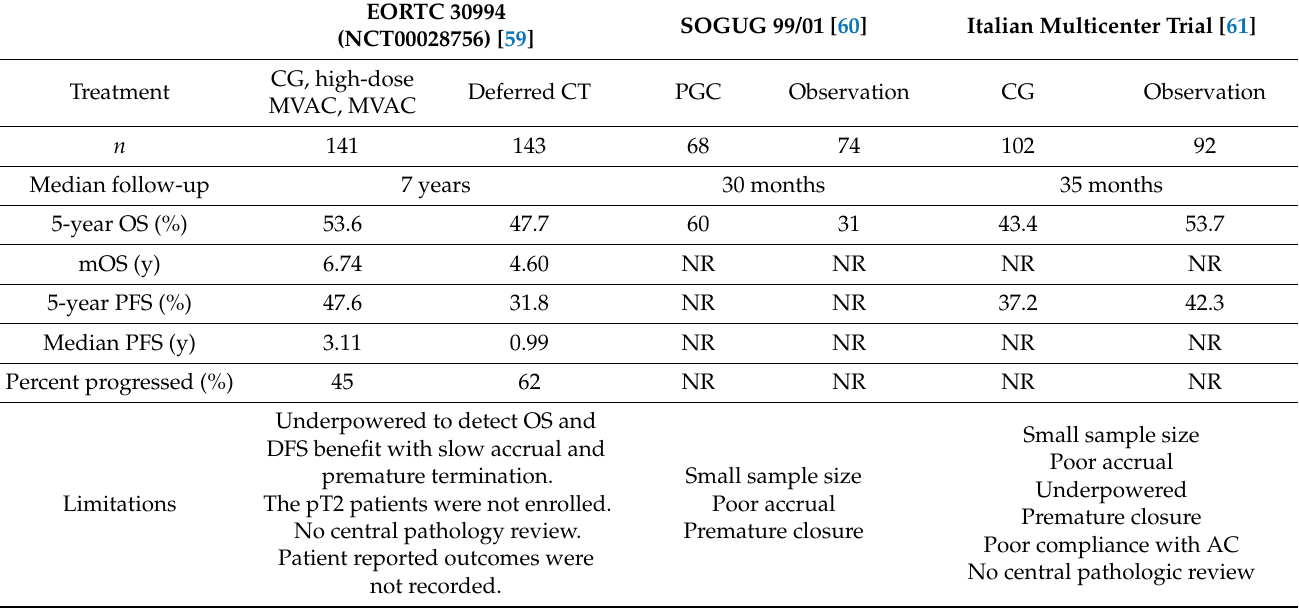
Table 4. Summary of phase 3 trials for adjuvant chemotherapy in